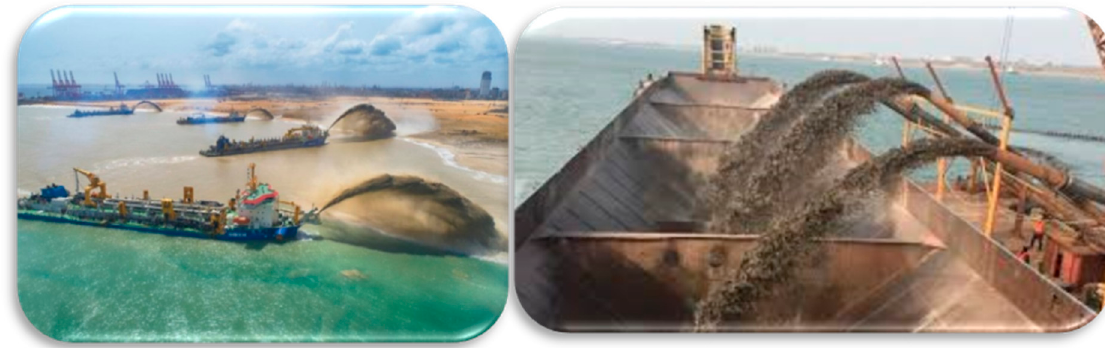
Figure 5. The construction